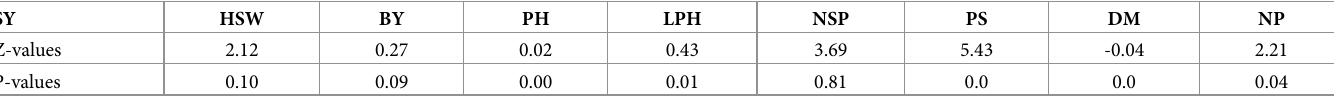
Table 5. Structural equational model representing regression for agronomic traits studied during 2017–18 and 2018–19. SY HSW BY PH